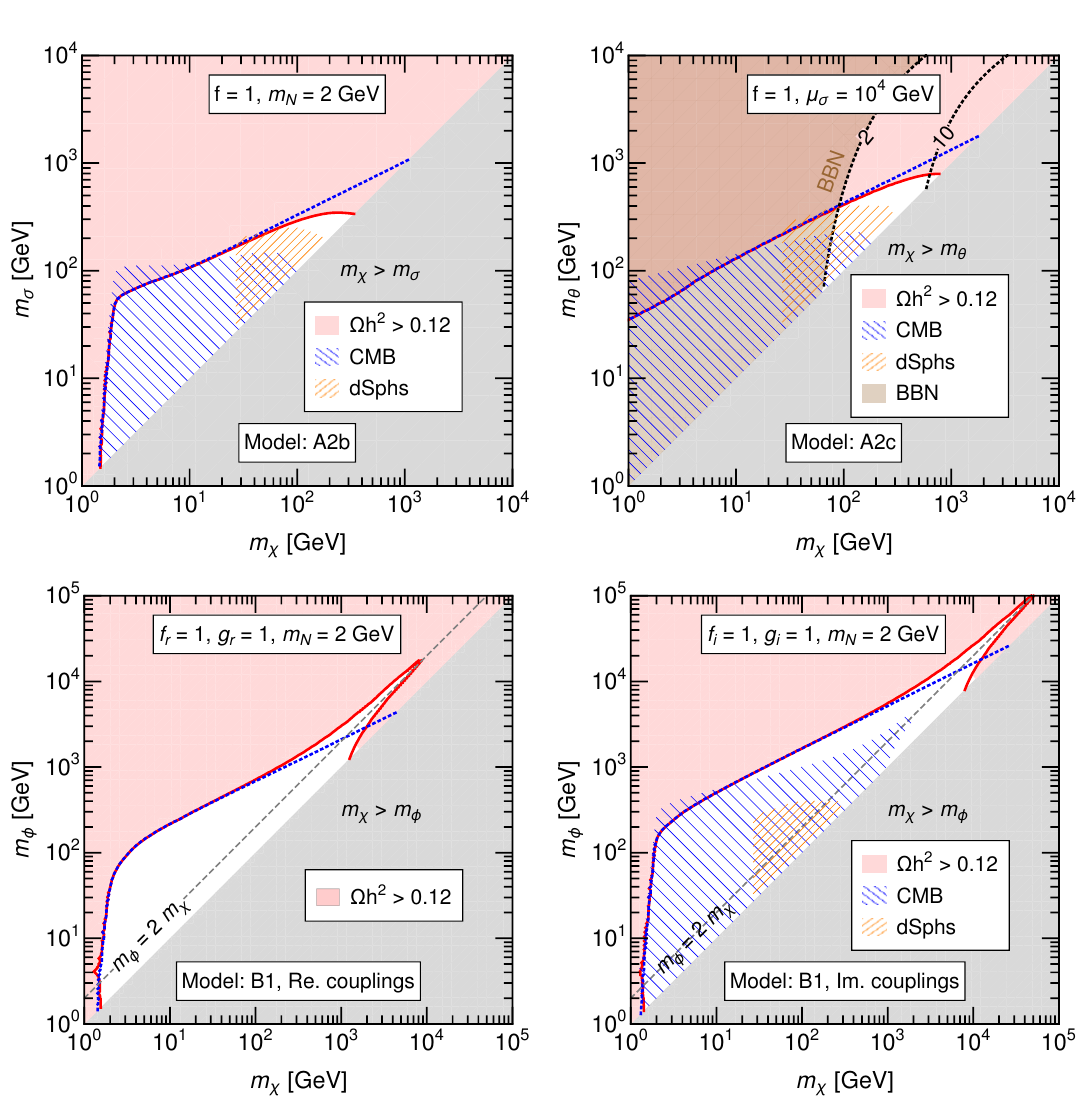
Figure 4 . Relevant parameter space of models A2b (top left), A2c (top right) and B1 with real (bottom left) and imaginary (bottom right) couplings. For each model, the values of the fixed parameters are specified in the upper region of the plots. Along the red line, the observed value of DM relic abundance is reproduced. The blue dotted line corresponds to the calculation of relic abundance in the EFT approach. When applicable, we present experimental bounds from ID and BBN. See details in the